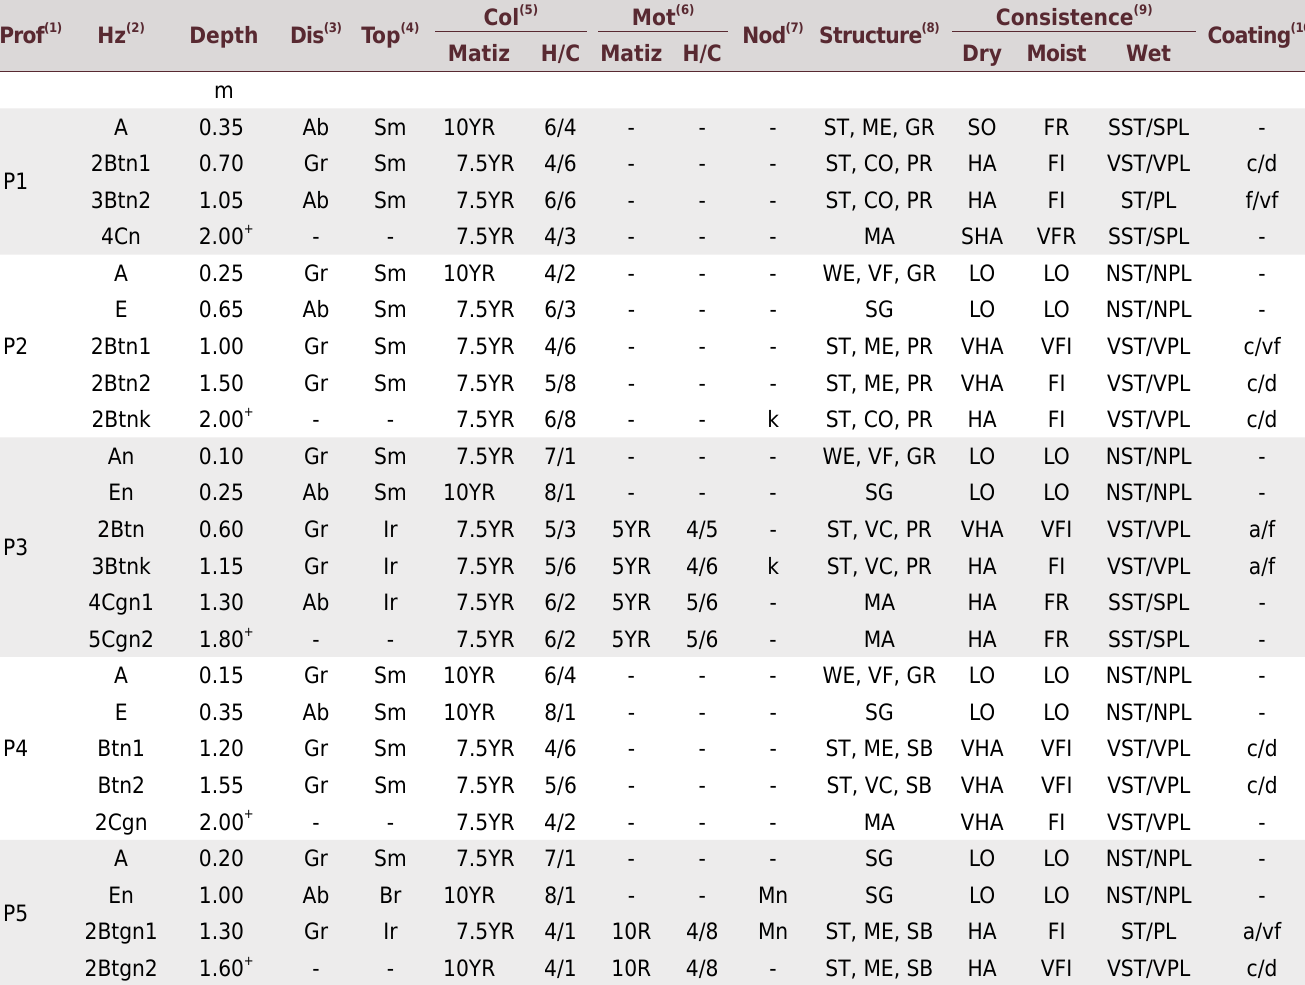
Table 1. Morphological description of the profiles opened at the five sites studied: P1, P2, P3, P4, and P5 Prof (1) Hz (2) Depth